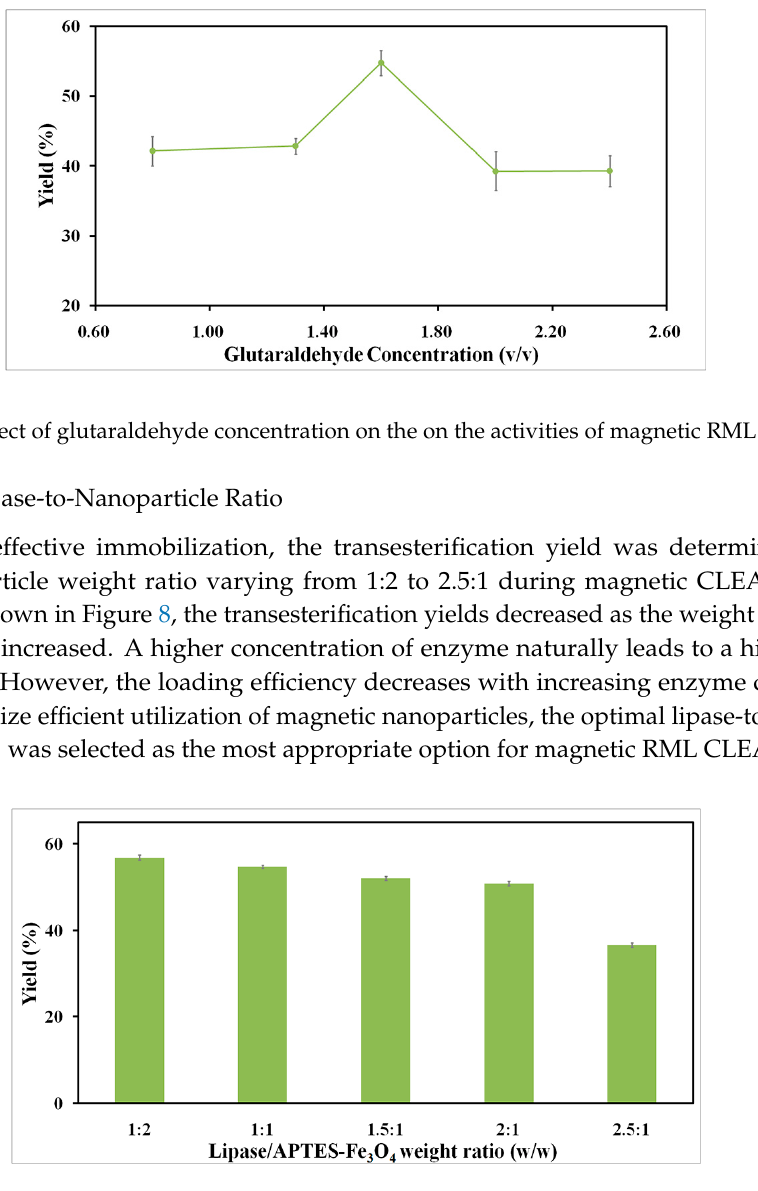
Figure 8. Effect of the lipase-to-nanoparticle ratio on the activity of magnetic RML CLEAs.